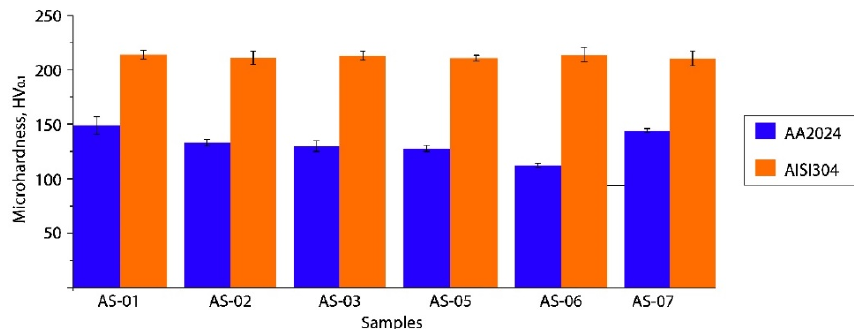
Figure 10. Microhardness distribution.